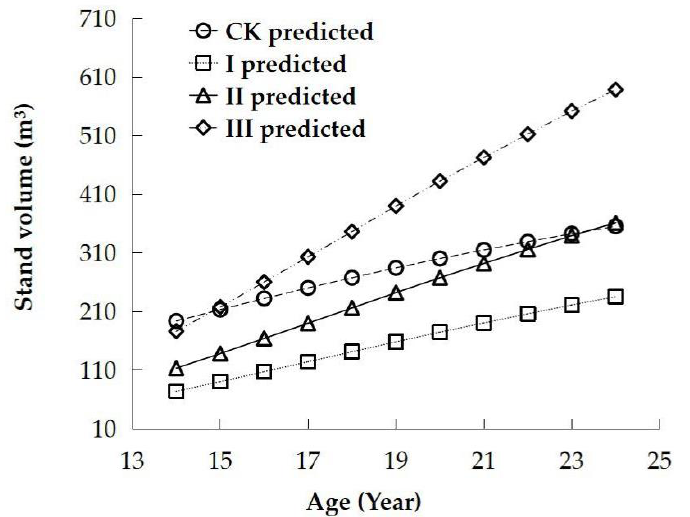
Figure 4. Stand volume predicted by the CROBAS-CL model. CK corresponds to no thinning, and I, II, and III correspond to thinning intensities of 70%, 50%, and 30%, respectively.